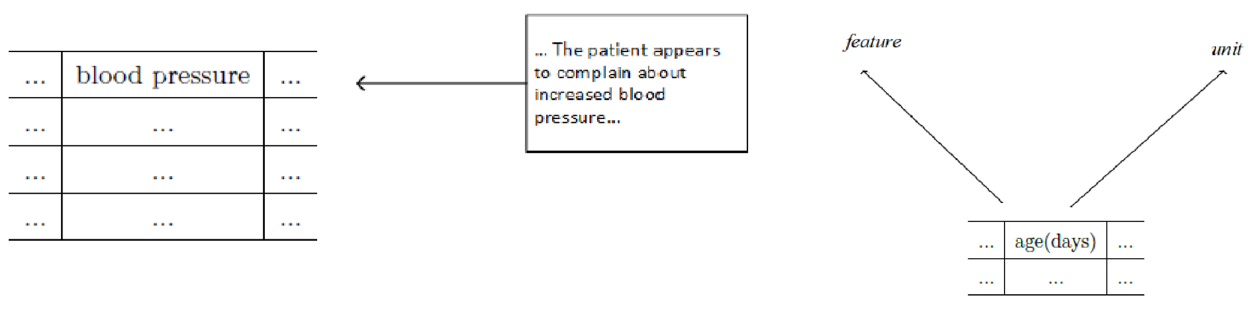
Figure 2. Transformation of text with patient notes to table with features represented as column ( left ) and application of NLP for analysis of table labels ( right